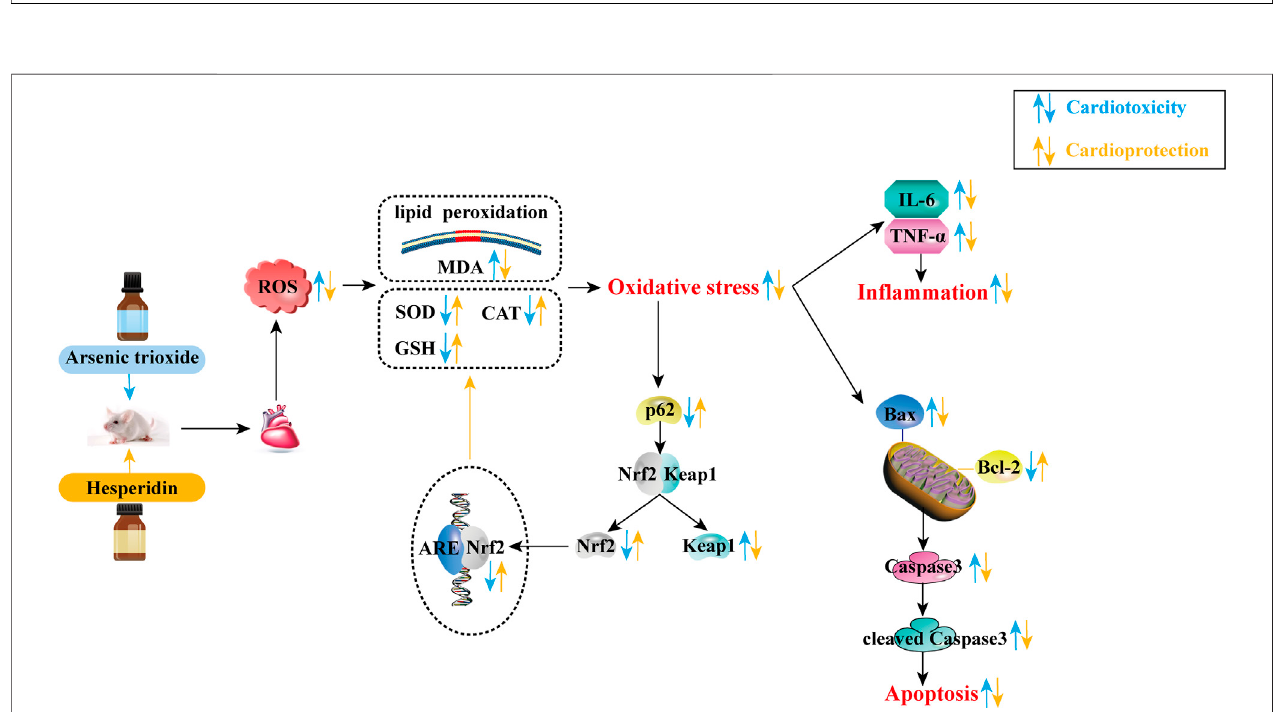
FIGURE 10 | The mechanism for cardioprotection of HES against cardiotoxicity induced by ATO.